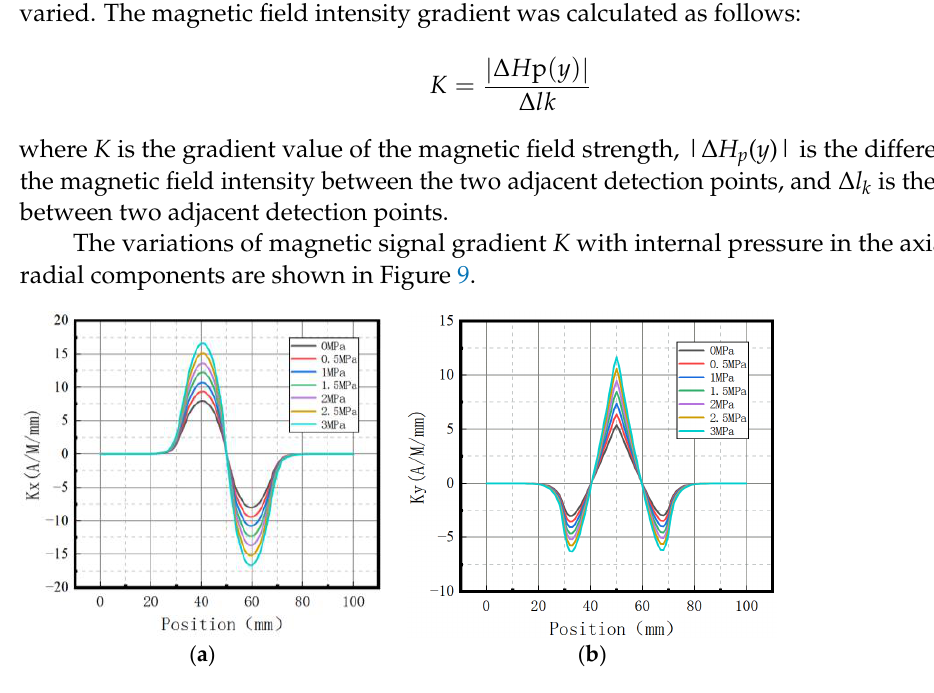
( b ) Figure 10. Kmax variation with internal pressure. ( a ) Axial component of Kmax ; ( b ) radial compo- nent of Kmax . It was revealed that in axial and radial components, Kmax linearly increased with the elevation of internal pressure. For an increase of pressure with an interval pressure of 0.5 MPa, the average change of Kmax for the axial component was 2.83 A/M/mm, and the average change of Kmax for the radial component was 1.95 A/M/mm. 3.1.4. Gradient Energy Factor S(K) A new parameter, namely the gradient energy factor S ( K ) , is presented in this study. S ( K ) is the area surrounded by the gradient curve of magnetic field strength and the ab- scissa axis, and it can more directly reflect the degree of stress damage. The variations of the S ( K ) parameter with internal pressure in the axial and radial components are shown in Figure 11. 0 . 00 . 51 . 01 . 52 . 02 . 53 . 0 8 10 12 14 16 18 Extreme value of axial gradient Linear fitting curve Kxmax(A/M/mm)